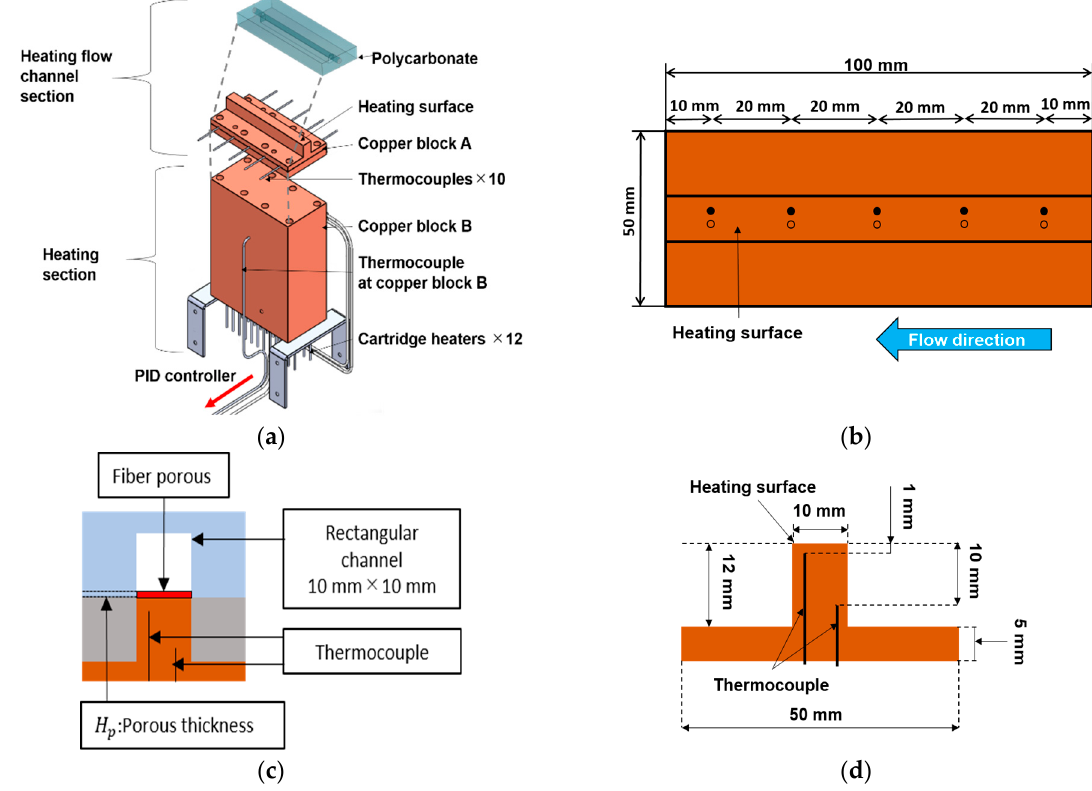
Figure 2. Test section details: ( a ) heating cooper block; ( b ) thermocouples distribution on the heating surface; ( c ) flow channel, ( d ) distance between each pair of thermocouples.